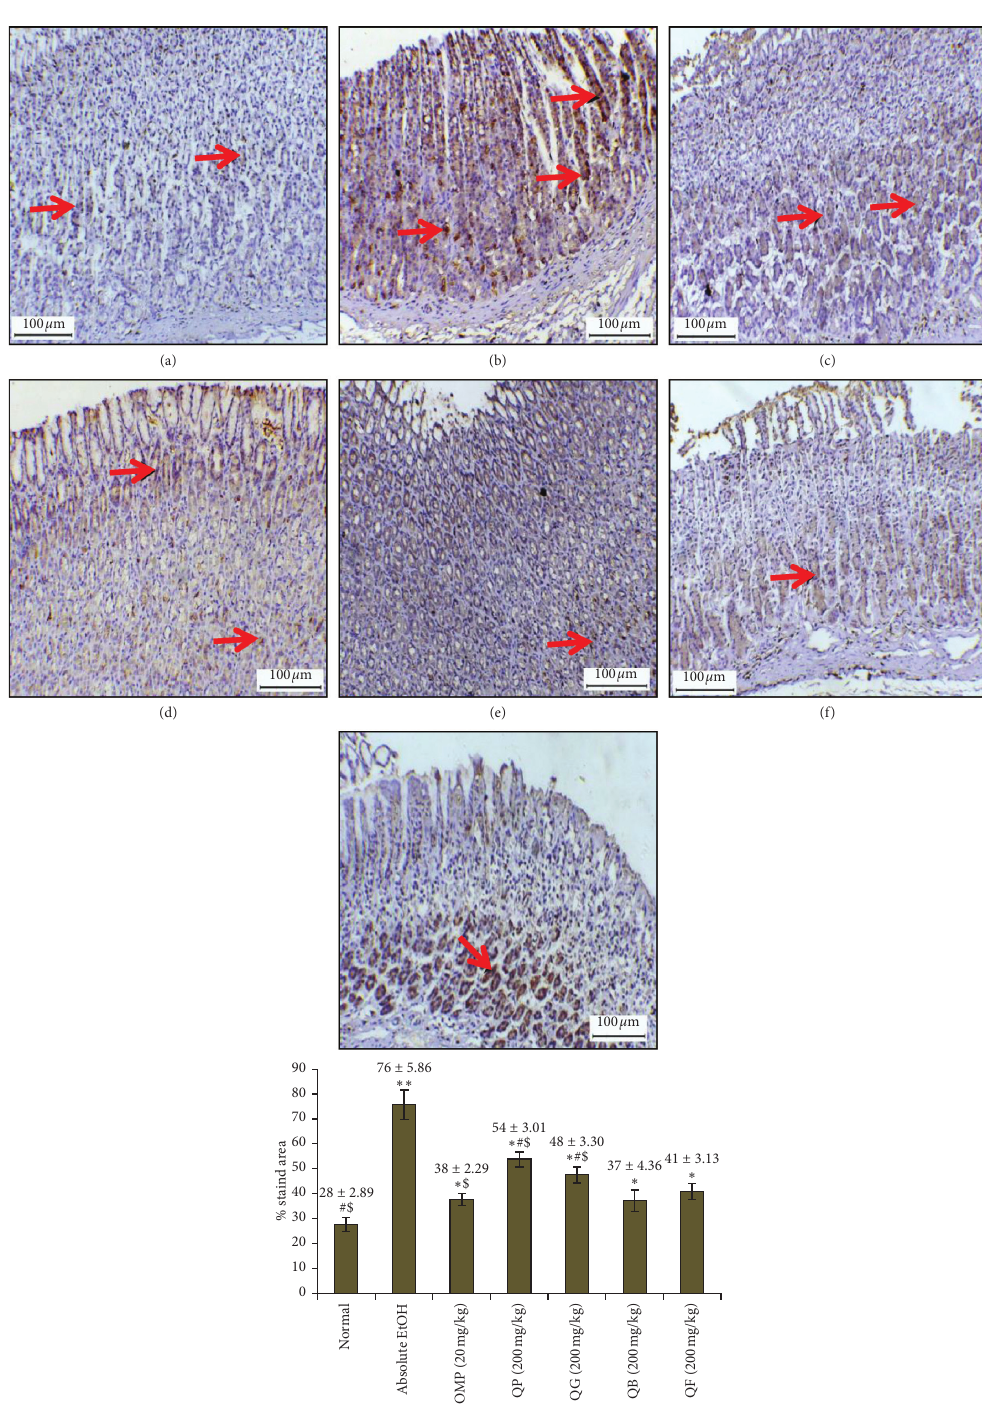
Figure 7: Effect of QP, QG, QB, and QF on the immunostaining of nitric oxide synthase (iNOS) enzyme in stomach sections from all animal groups. (a) Slight expression of iNOS in normal stomach. (b) Marked overexpression of iNOS throughout the whole mucosal part of the stomach treated with absolute EtOH at dose of 5mL/kg (red arrow). (c) Slightly expressed iNOS in the stomach treated with omeprazole (20mg/kg). (d) Moderately immunoexpressed iNOS in the stomach treated with QP (quinoa seeds cooked under high pressure, 200mg/kg). (e) Stomach treated with QG (first stage-germinated quinoa seeds, 200mg/kg) showing mild expression of iNOS in the gastric mucosa. (f) Stomach treated with QB (quinoa seeds fermented by Lactobacillus plantarum bacteria, 200mg/kg) showing more immuno-iNOS expression in the lower part than the upper part of gastric mucosa. (g) Stomach treated with QF (quinoa seeds fermented by Rhizopus oligosporus fungus, 200mg/kg) showing clear expression of iNOS in the upper part with minor expression in the lower part of the gastric mucosa. Quantitative estimation of immunohistochemical staining based on the determination of the % positive-stained area from 6 images/group using ImageJ analysis software is charted down the images. ∗∗ p < 0 . 05 compared to normal. ∗ p < 0 . 05 compared to absolute EtOH. # p < 0 . 05 compared to omeprazole OMP. $ p < 0 . 05 compared to